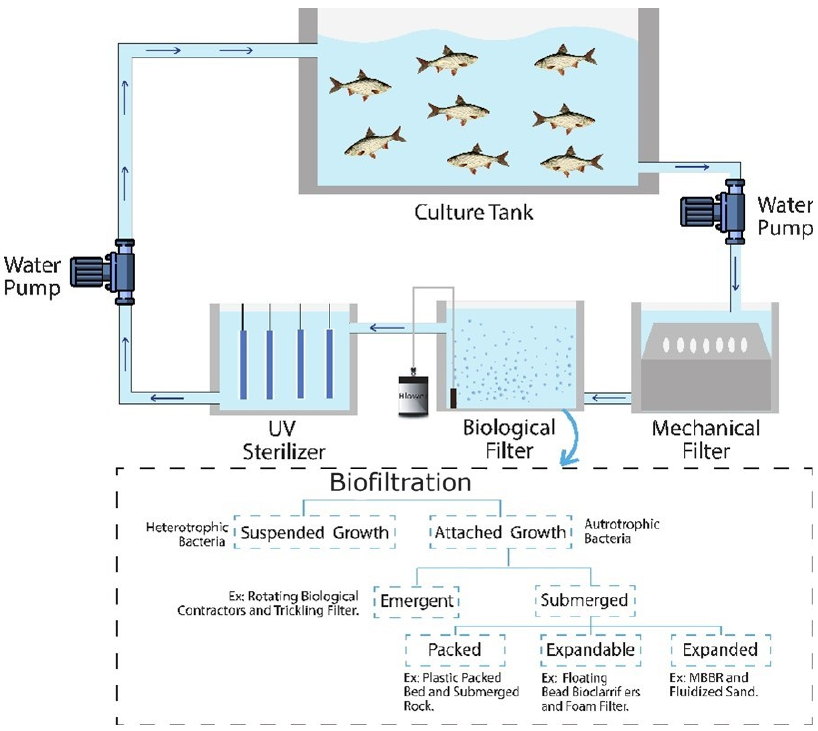
Figure 2. Types of biofilters in RASs.